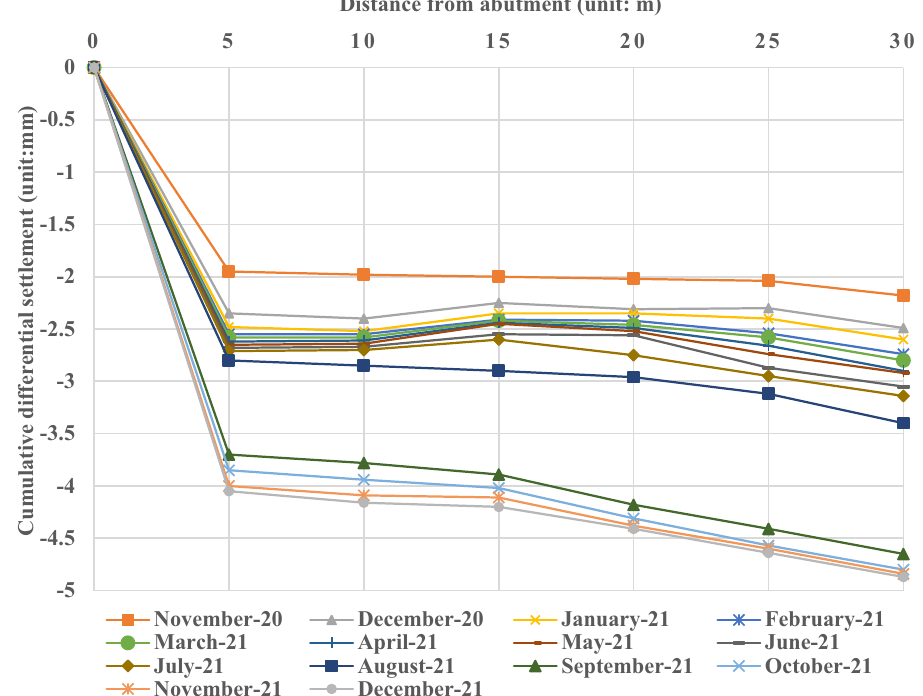
Figure 4. Cumulative differential settlement of monitoring points.